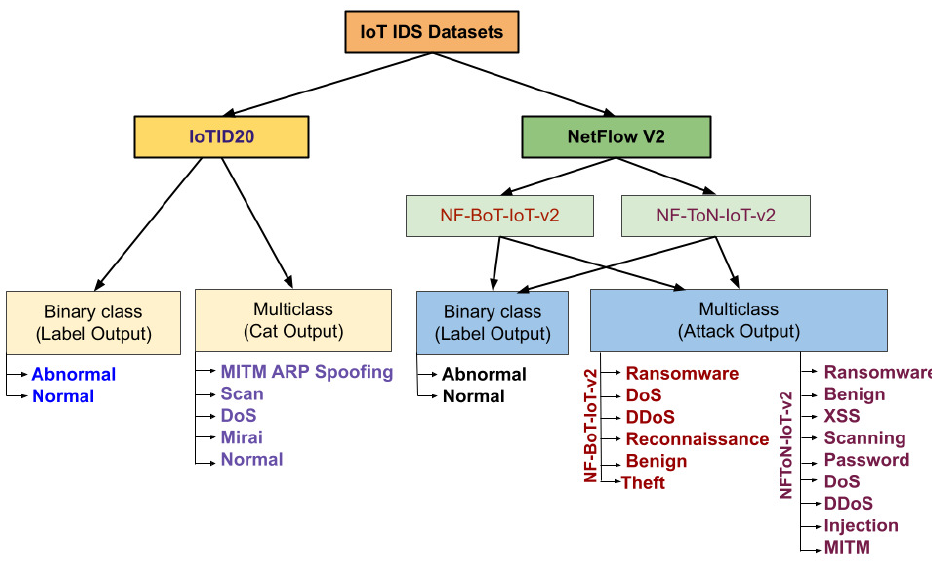
Figure 4. IoT IDS dataset used.